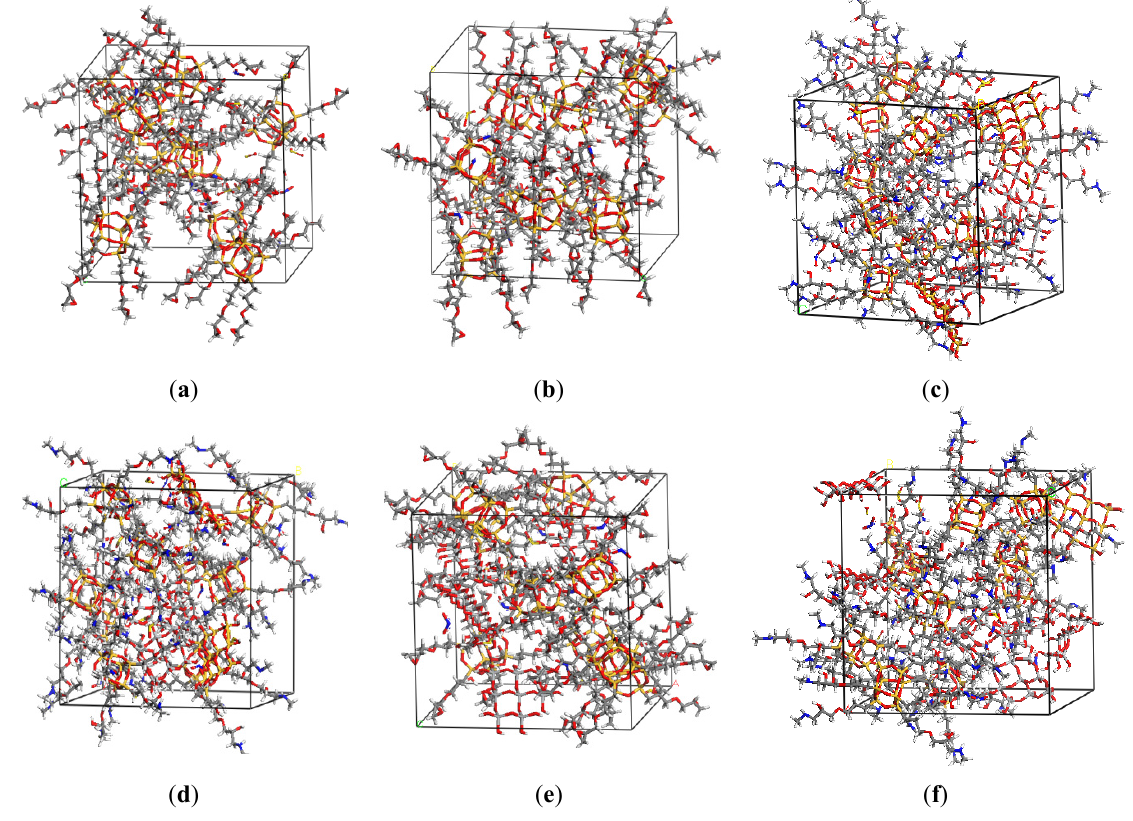
Figure 1. Model cells for f-GSTT ( i = 0, 5, 10, 15, 20 and 25 wt%) containing GS i % oligomers, H O, NO and SO gas molecules, and 5–25 wt% TiO 2 2 2